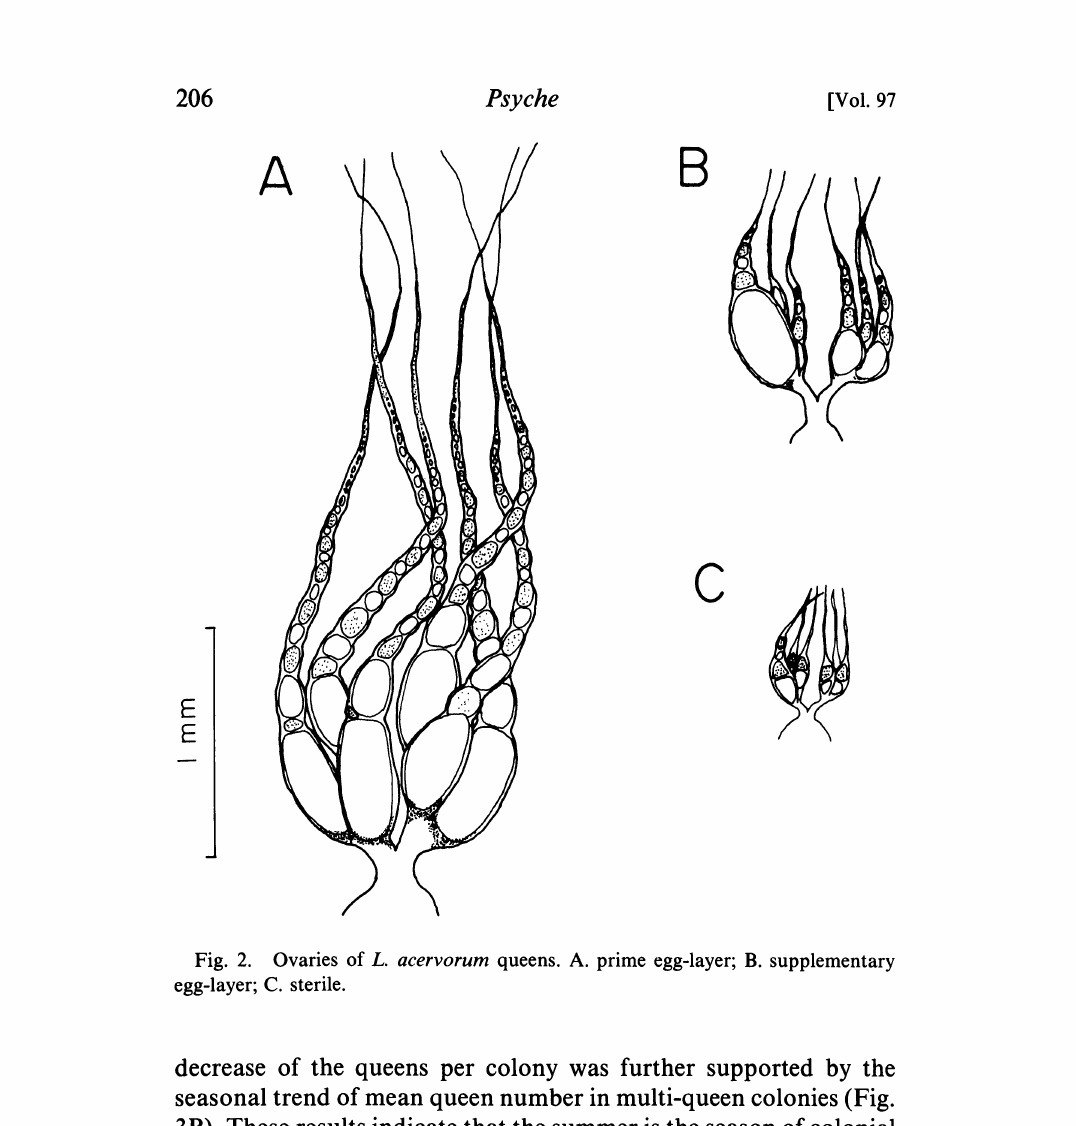
Fig. 2. Ovaries of L. acervorum queens. A. prime egg-layer; B. supplementary egg-layer; C.